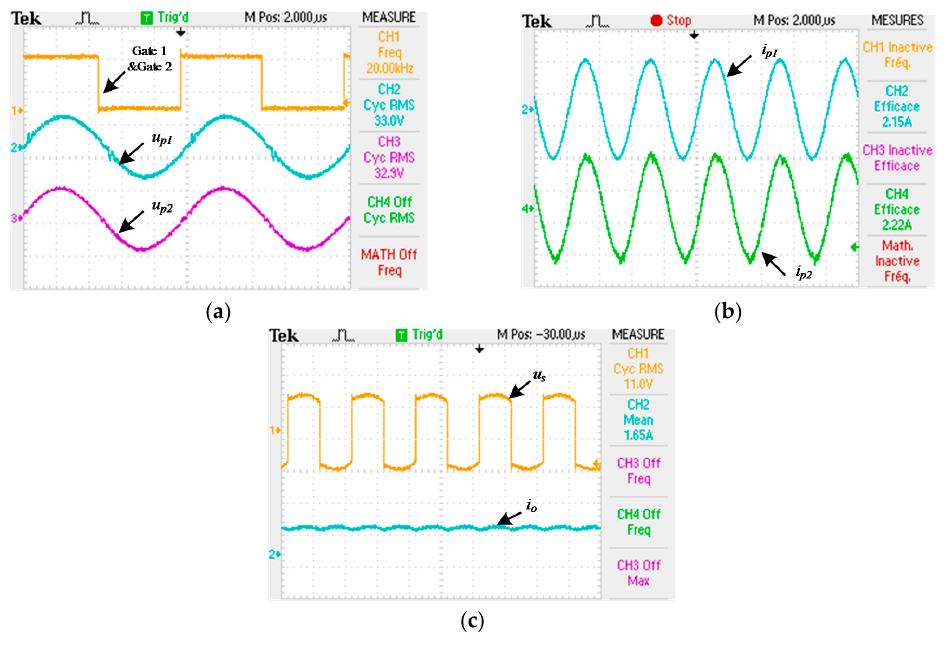
Figure 12. Experiment results of the DEU-WPT system: ( a ) Voltage waveform of the primary coil in DEU-WPT; ( b ) Current waveform of the primary coil in DEU-WPT; ( c ) Load waveform in DEU-WPT